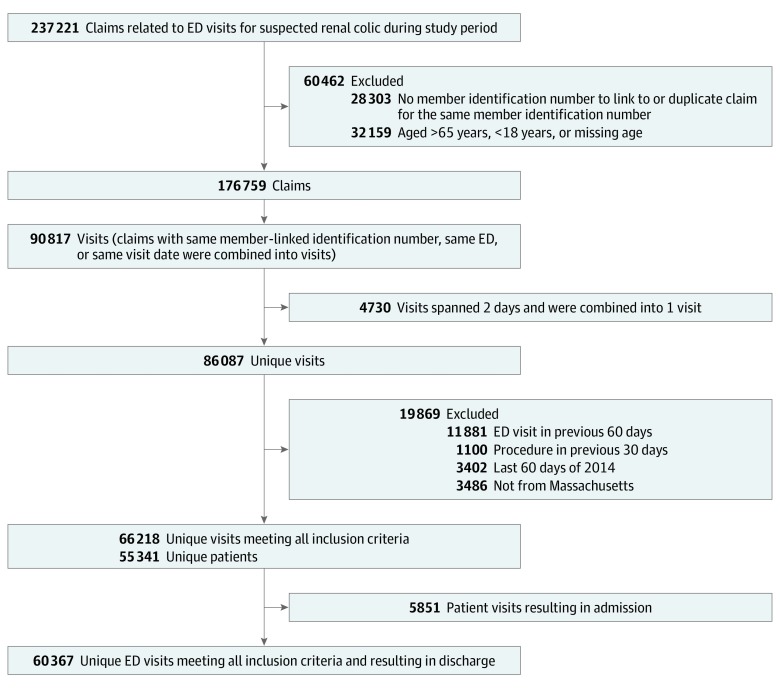
Flow of Included PatientsED indicates emergency department.